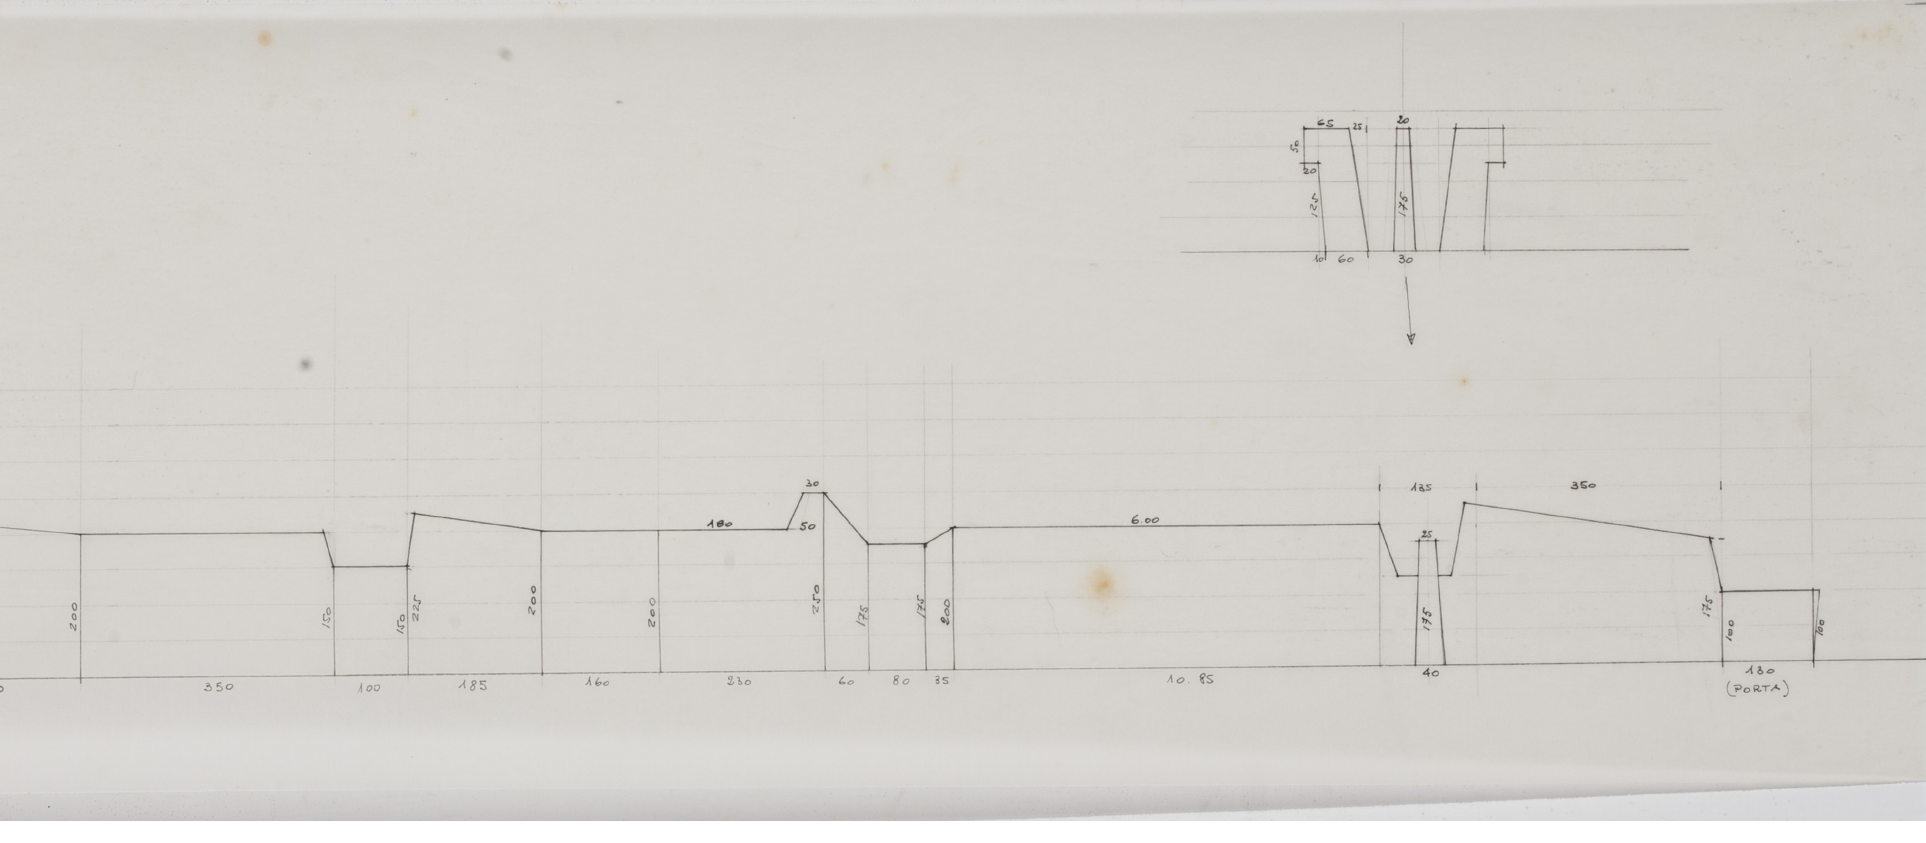
IMG.7: elevation of a se- quence of panels, ink on transparency,